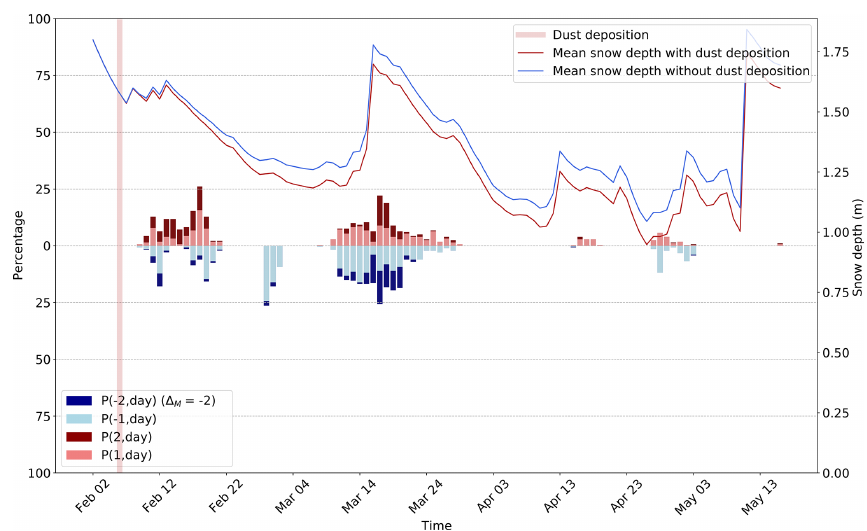
Figure 10. Evolution of the daily (cid:49) M index introduced in Sect. 2.3.1 for a west-facing slope at 3000m and for the observed dust event of February 2021.